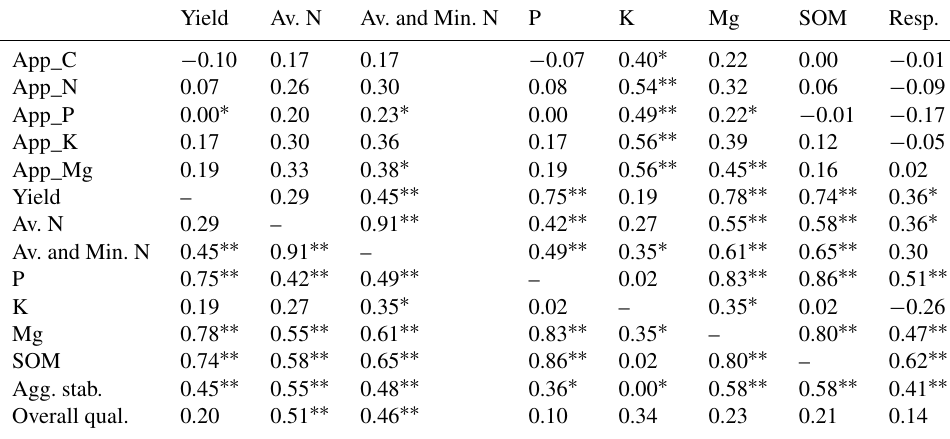
Mg 0.78 ∗∗ SOM Agg. stab. Overall qual.